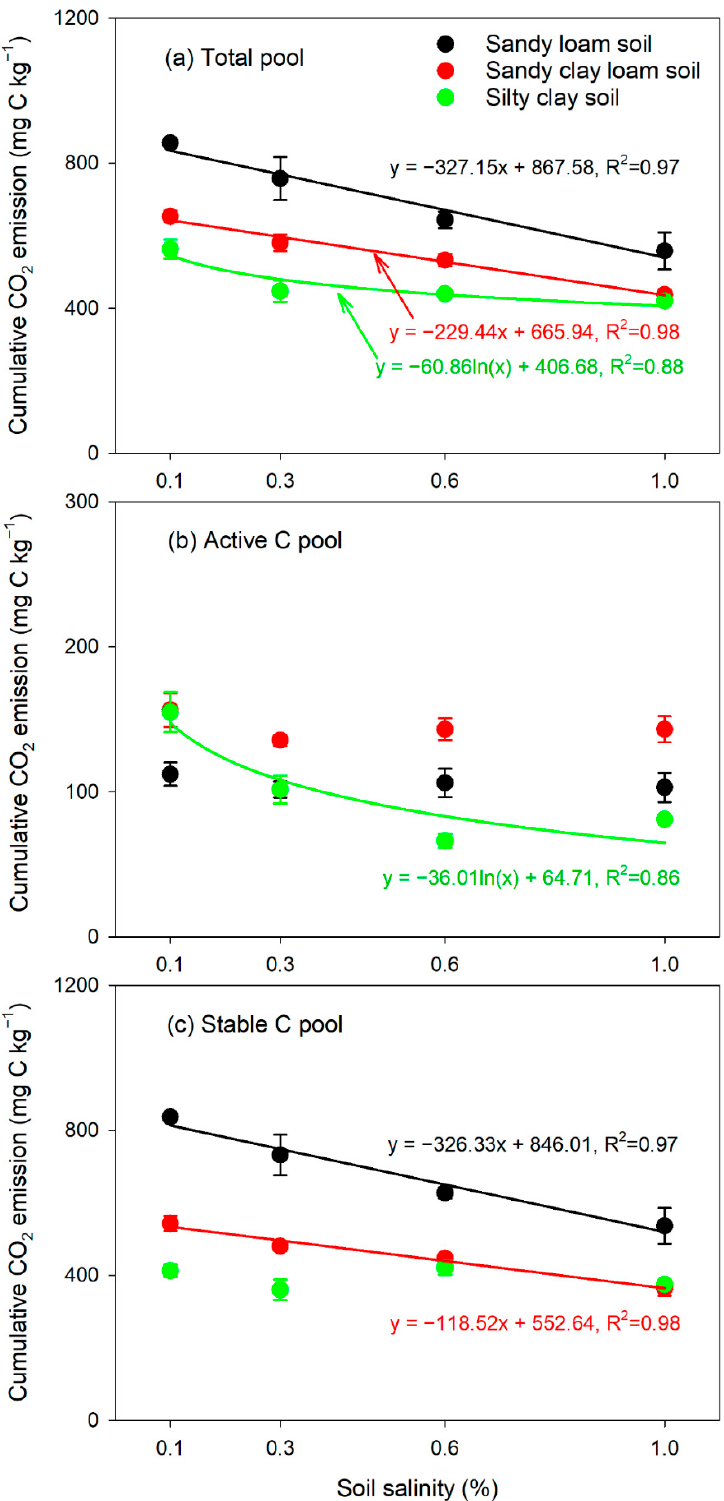
Figure 2. Relationships between cumulative CO 2 emissions from total ( a ), active ( b ) and stable ( c ) carbon pools and salinity in the sandy loam soil, sandy clay loam soil and silty clay soil. Error bars indicate the standard error of the mean ( n = 3).